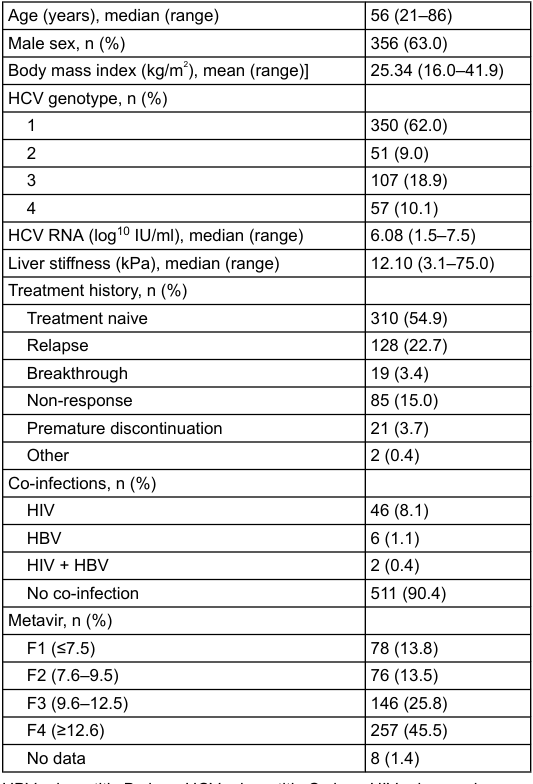
Figure 1: Flow chart of patient recruitment.